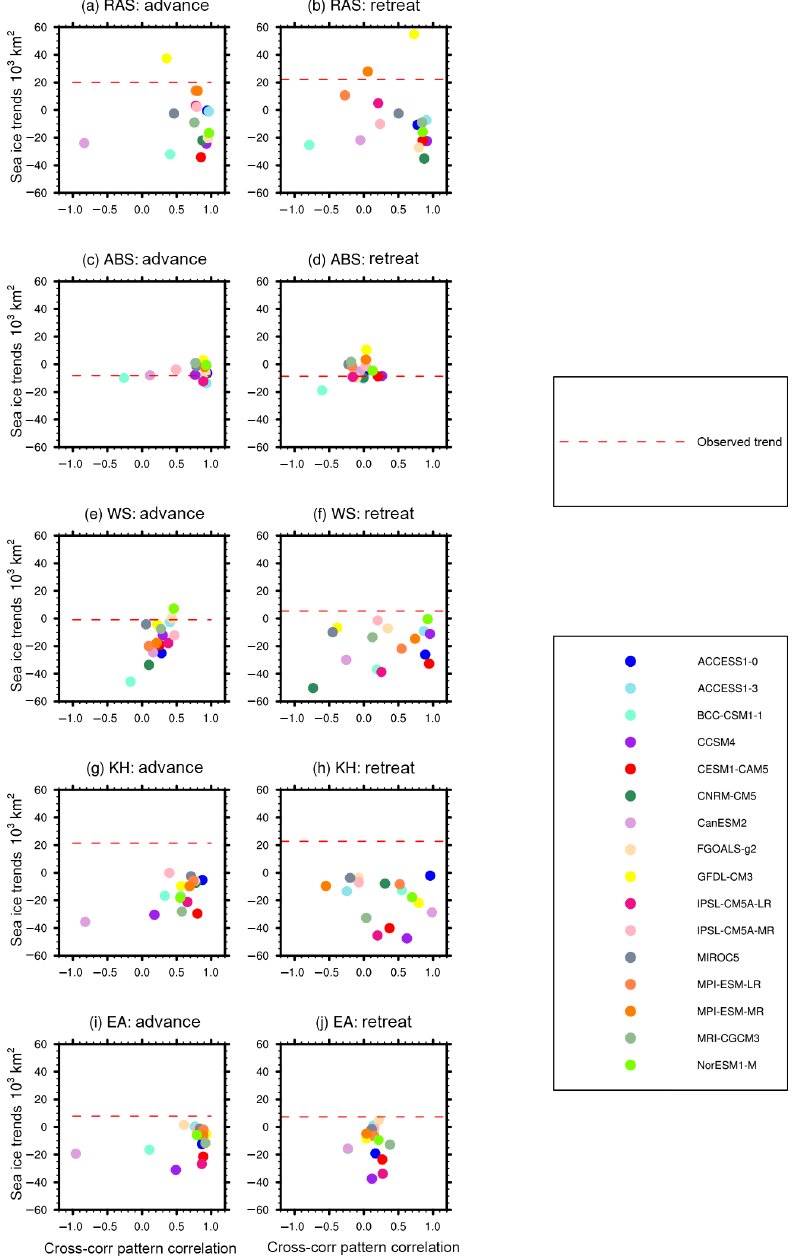
Figure 3. Pattern correlation values comparing observations and CMIP5 model correlation maps of SLP and SIE against the model historical (1979–2005) SIE trends for: Ross/Amundsen seas (RAS) during (a) advance and (b) retreat; Amundsen/Bellingshausen seas (ABS) during (c) advance and (d) retreat; Weddell Sea (WS) during (e) advance and (f) retreat; King Hakon VII (KH) during (g) advance and (h) retreat; and East Antarctica (EA) during (i) advance and (j)